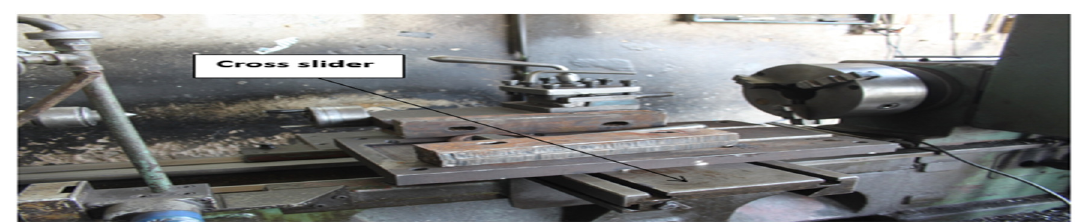
Fig. 7: Final setup of the fixture on the lathe machine